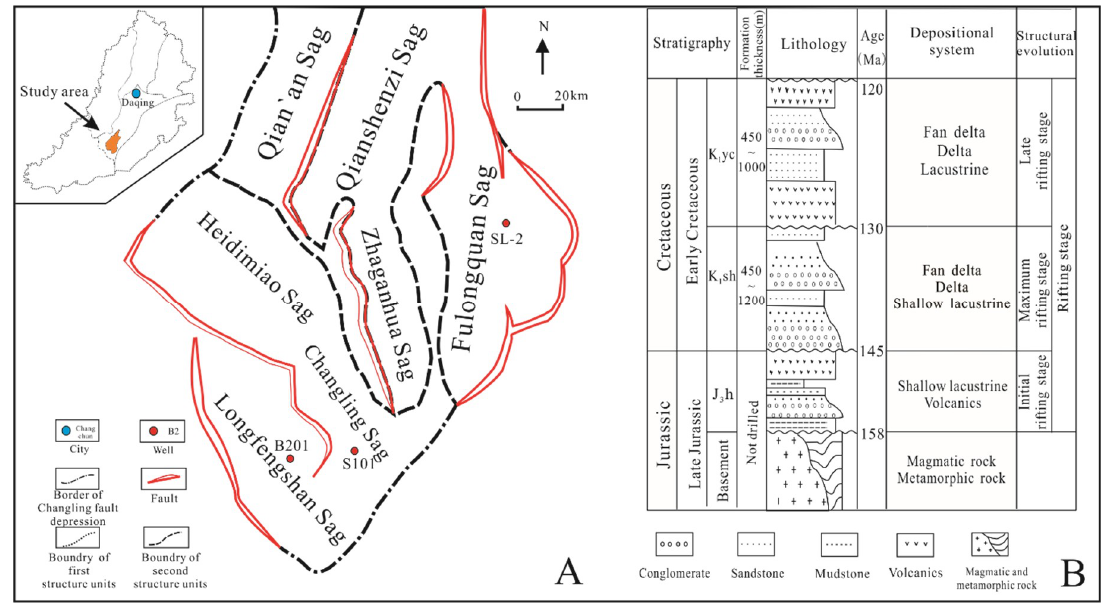
Figure 1. ( A ) Maps showing the location and the structure distributions in the Changling Fault Depression (CFD); ( B ) stratigraphy column showing petrology and depositional facies of the Shahezi Formation in CFD (modified after Gao et al., 2018 [30] and Cai et al., 2017 [31]).